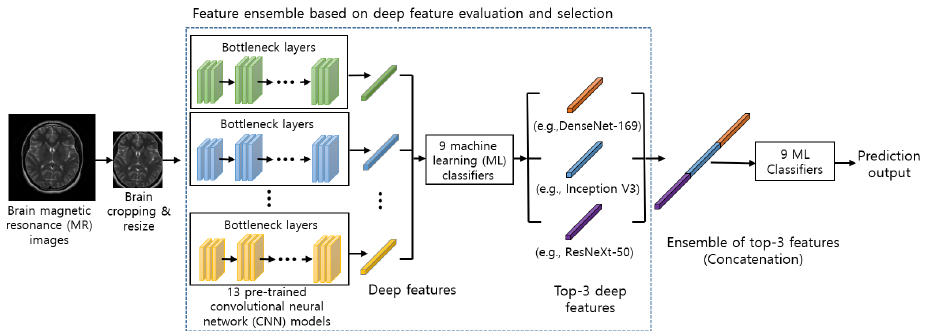
Figure 1. Architecture of our proposed model using feature ensemble based on deep feature evalua- tion and